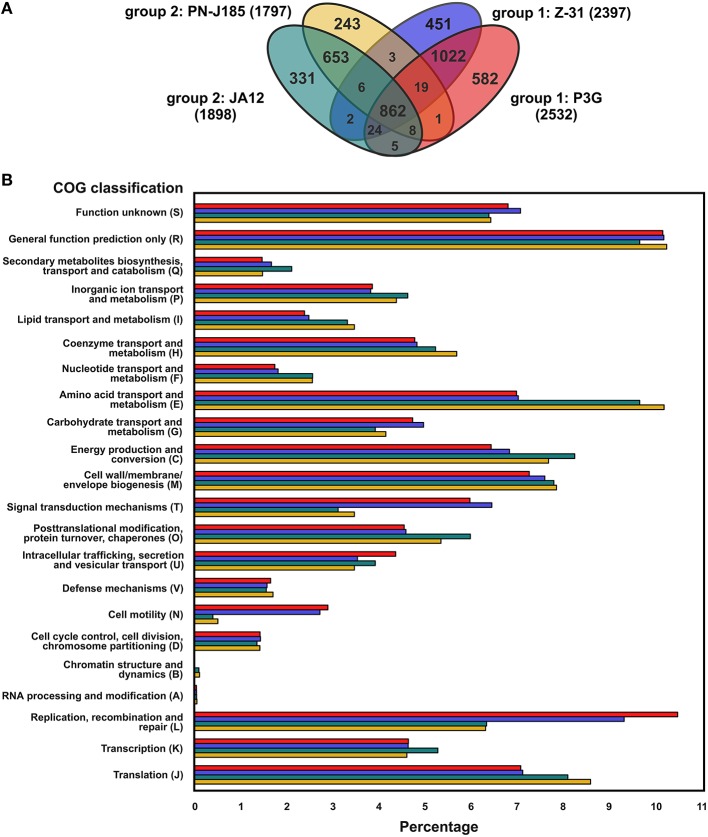
Summary of homologous proteins of the four “Ferrovum” strains and distribution of protein-coding genes assigned to the COG classification. (A) Core genome and overlaps between the genomes were determined based on the identification of homologous proteins (group 2 strain JA12, turquoise; group 2 strain PN-J185, yellow; group 1 “F. myxofaciens” sp. Z-31, blue; group 1 “F. myxofaciens” P3G, red). The number of proteins involved in the analysis for each of the genomes is indicated in parentheses. Predicted mobile genetic elements were excluded. (B) Percentage of assigned protein-coding genes to COG classes is given for all genomes with color coding according to (A). All protein-coding genes were included in the prediction of the COGs. Results of the predictions are listed in Supplementary Table 2.